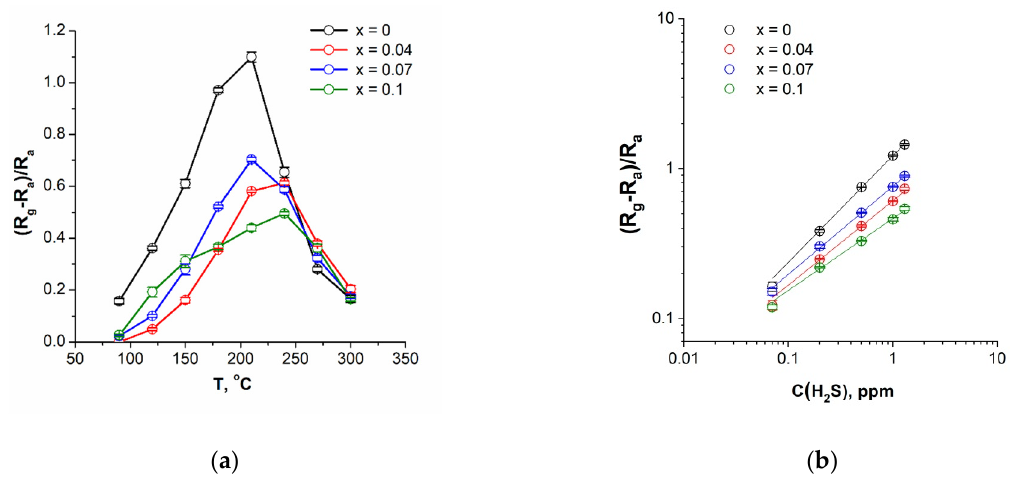
Figure 6. ( a ) The temperature dependence of the sensor signal at the range of 90–300 °C in the presence of H 2 S (1 ppm) in dry air; ( b ) Dependence of the sensor signal value on the concentration of H 2 S at 210 °C in dry air.